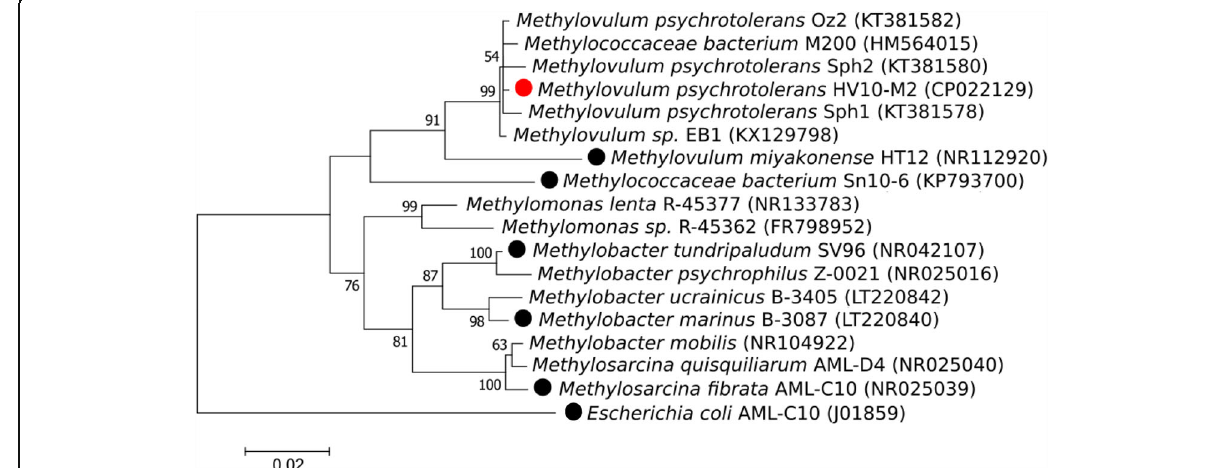
Fig. 2 Phylogenetic tree. The tree is based on the 16S rRNA gene sequences of the best hits of cultured strains in the nucleotide database from NCBI (retrieved on June 5, 2017). The tree was reconstructed by using maximum likelihood analysis and the Jukes-Cantor nucleotide substitution model as implemented in MEGA v7 [40]. Robustness of the tree was determined using 1000 bootstrap replicates. Sequences were aligned with MUSCLE [41] in MEGA v7. The tree was rooted against the 16S rRNA gene sequence of Escherichia coli . Accession numbers are provided within parenthesis. The strain presented in this study is marked with a red dot. Strains with available genome data are marked with black dots. Bootstrap values less than 50 are not